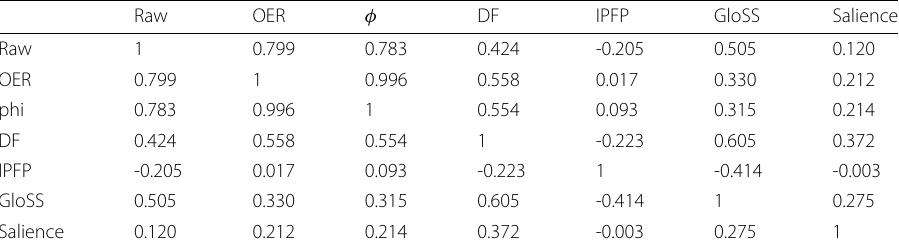
Table 7 The correlation matrix for the eigenvector centrality of nodes between different networks Raw OER φ DF